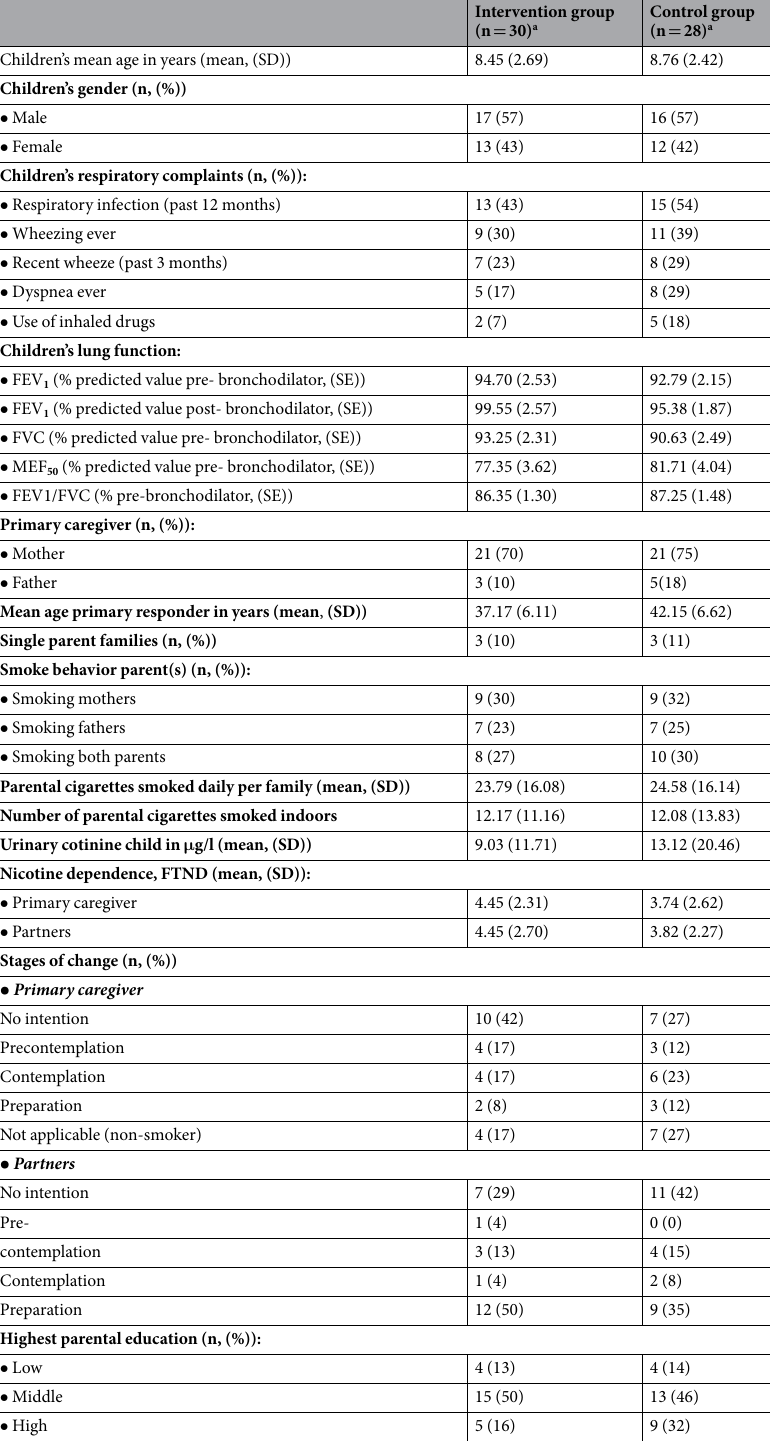
Table 1. Baseline characteristics. a Except for the child’s age and gender, baseline characteristics were not available for n = 6 families in the intervention group and n = 2 families in the control group due to dropout (lost- of-follow up) before baseline measurement. Test of the baseline group difference: p > 0.05 for all variables, indicating absence of severe bias due to